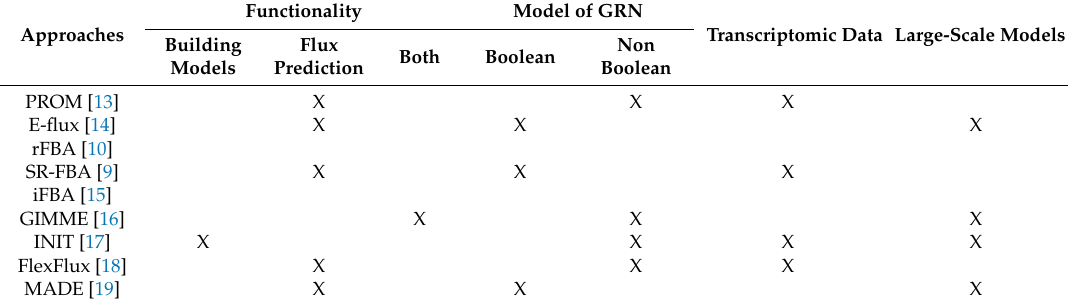
Table 1. Overview of the main approaches used to integrate the genome-scale metabolic and gene regulatory networks: Classification of methods according to their intended functionality regarding metabolic flux distribution prediction, context-specific models building, or both. These methods can be also divided into two categories regarding how genes activity is modeled in the gene regulatory network (GRN); for the Boolean framework, each gene in the GRN is in one of two states: active or inactive. The requirement of transcriptomic data as input to determine the active and inactive sets of genes in a given condition is another grouping criterion. Some approaches cannot deal with the large-scale model, especially those that are based on manually reconstructed